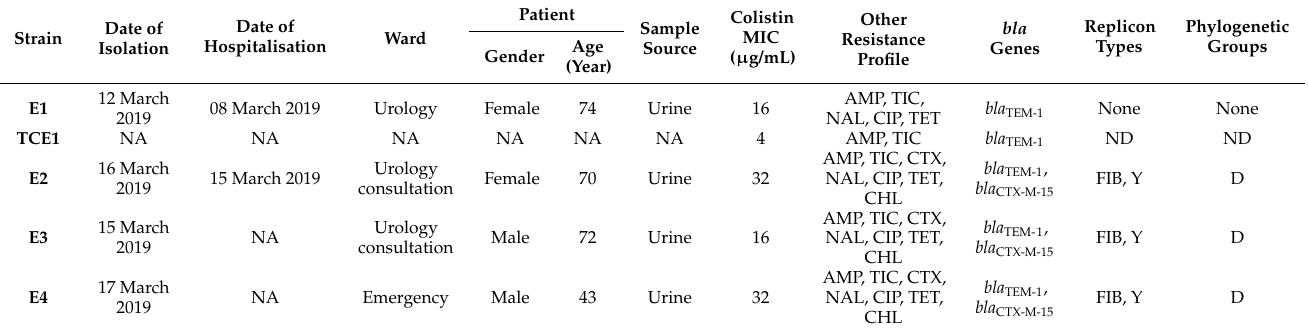
Table 3. Characteristics of the four E . coli isolates carrying mcr-1 and TCE1 E. coli